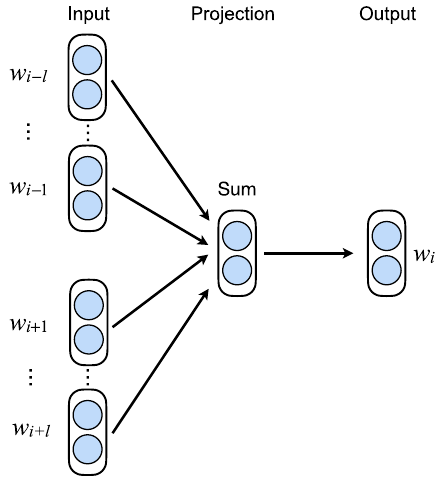
Fig. 9 Architecture of CBOW model.